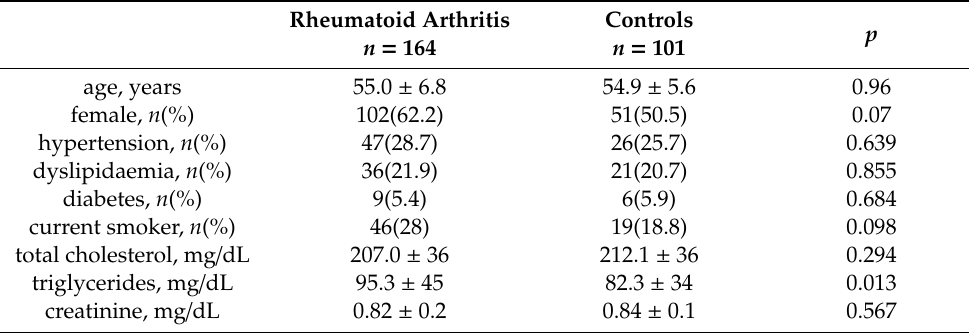
Table 1. Demographic characteristics and cardiovascular risk profile of rheumatoid arthritis (RA) patients and controls.